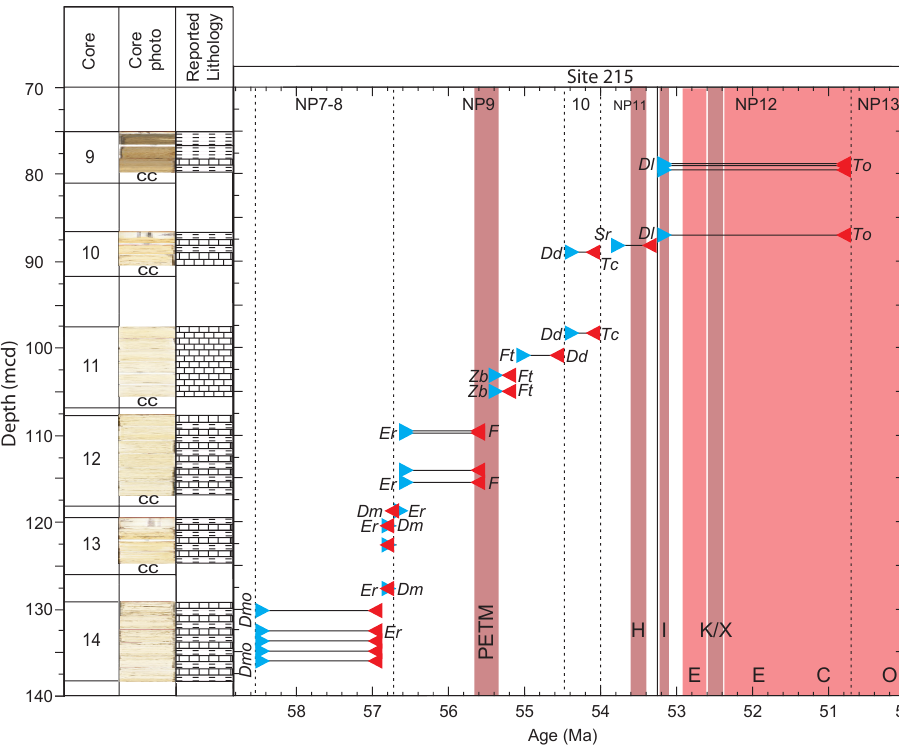
Figure 5. The depths of key nannofossil datums (bases – blue triangles; tops – red triangles) identified at Site 215. To and Dl indicate presence of both T. orthostylus and D. lodoensis . Dl and Sr indicate absence of D. lodoensis and presence of S. radians . Tc and Dd indicate presence of both T. contortus and D. diastypus . Dd and Ft indicate absence of D. diastypus and presence of a few to rare F. tympaniformis . The two samples marked Ft and Zb indicate presence of both F. tympaniformis and Z. bijugatus , and dominance in abundance of Z. bijugatus over F. tympaniformis . The four samples marked F and Er show presence of diverse and abundant Fasciculithus spp. and absence of E. robusta . Er and Dm indicate presence of both E. robusta and D. multiradiatus . Dm and Er indicate absence of D. multiradiatus and presence of E. robusta . The five samples marked Er and Dmo indicate absence of E. robusta and presence of D. mohleri . Age estimates from Agnini et al. (2006, 2007) and calcareous nannofossil NP biozones from Martini (1971). Solid black vertical lines denote precisely known NP biozone boundaries; lines are dashed if boundary is not precisely known. Note lithological facies key in Fig.